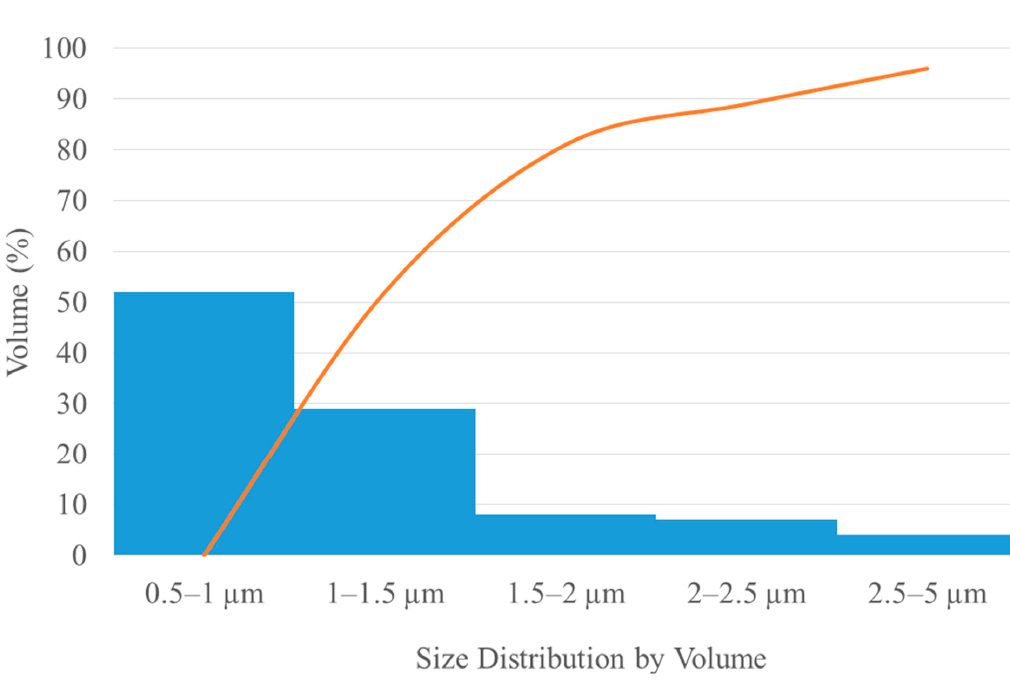
Figure 4. A histogram of the particle size distribution.